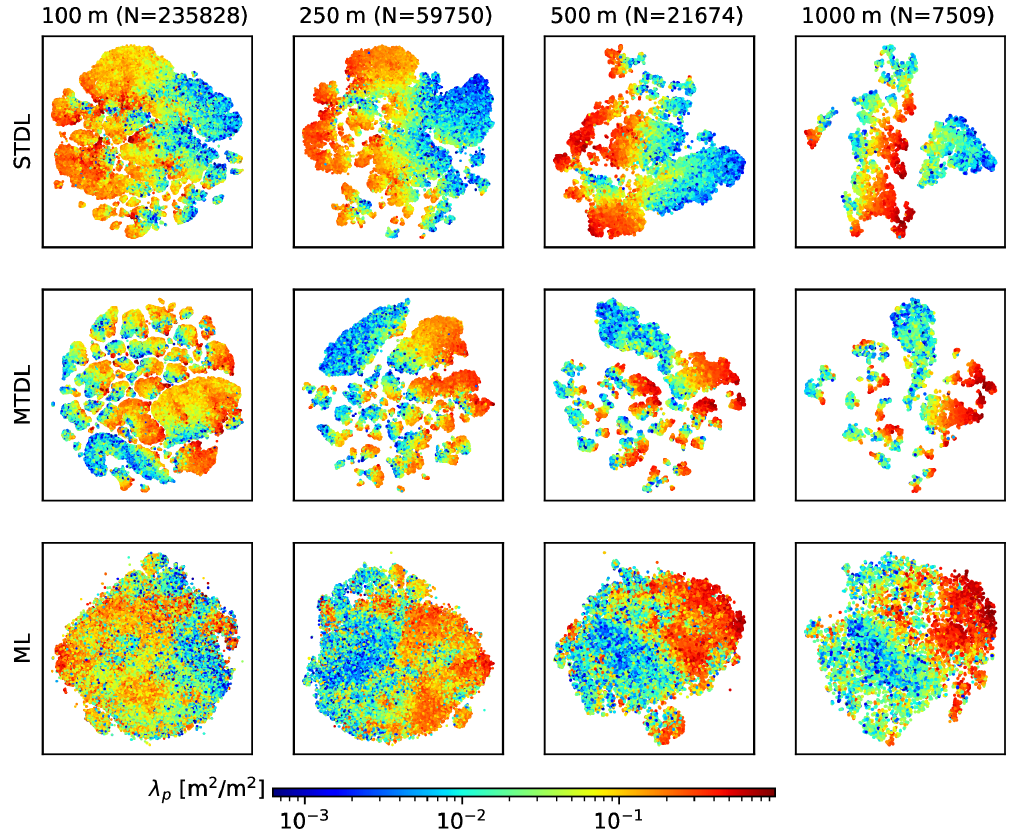
Figure 13. Visualization of features for building footprint prediction in D test , 2 using t -SNE.